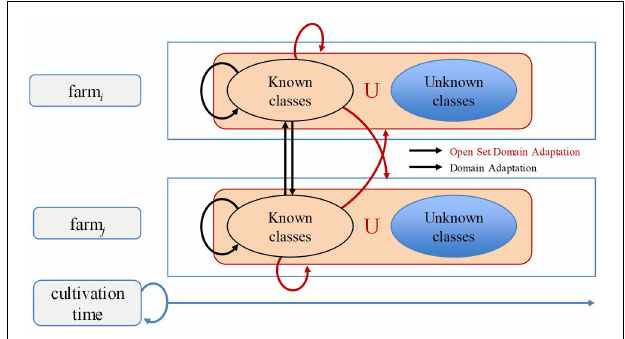
FIGURE 1 | Recognition problem of plant diseases with open set domain adaptation. Our framework addresses open set domain adaptation at farm-level and across different farms. Known classes represent existing classes in the source domain, while unknown classes represent non-existing ones. Since data may vary across farms and throughout the cultivation time, many changes could appear while dealing with novel